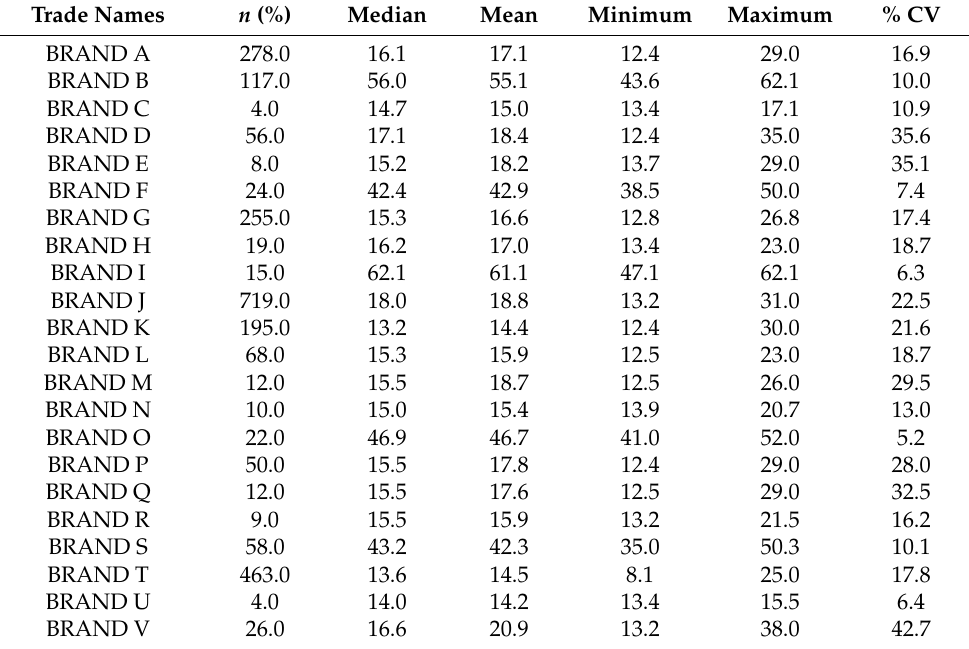
Table A1. Descriptive statistics of medicine code A02BC01 (omeprazole 40 mg, parenteral) used in this